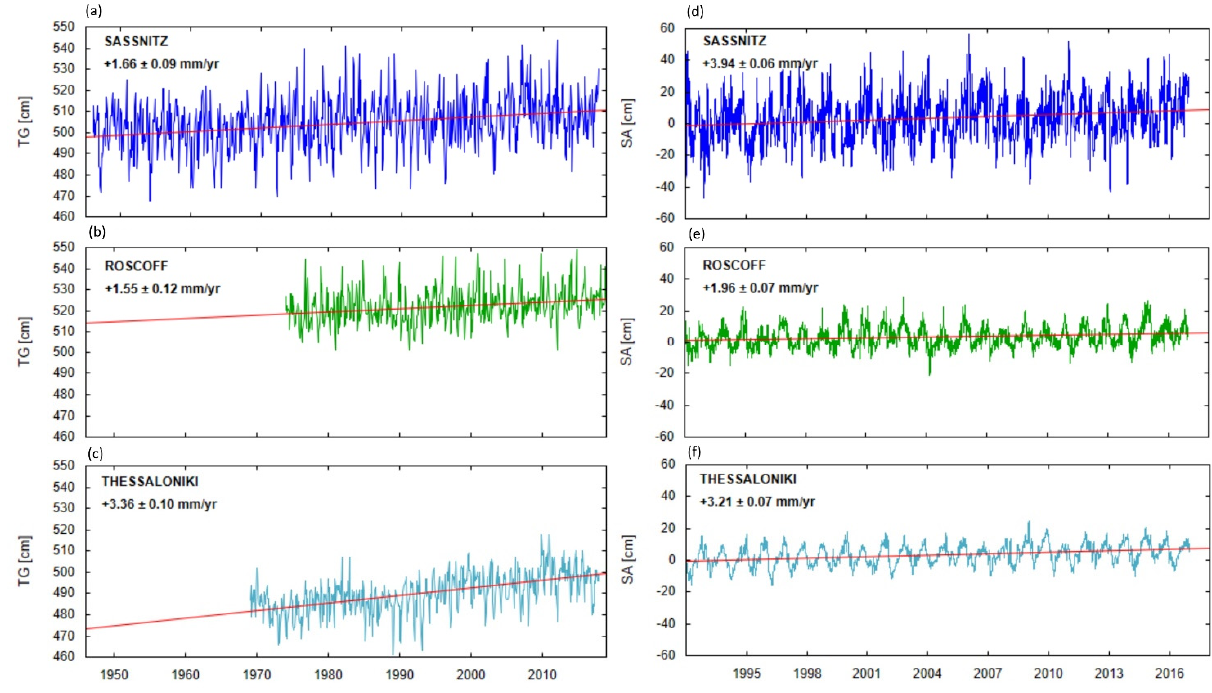
Figure 2. ( a – c ) Time series of mean sea level anomalies based on TG data. ( d – f ) Time series of mean sea levels based on SA data. The time series are displayed with arbitrary offsets for presentation purposes. The units are in centimetres. Gridded daily sea level anomalies with a resolution of 0.25 × 0.25 degrees and the time series for January 1993 to December 2017 from the Copernicus Marine and Environ- ment Monitoring Service (CMEMS) were used. The time series of altimetric data (one series for each altimetric observation point) were obtained. This set combines data from several altimetry missions. Altimetric measurements were corrected for atmospheric effects (ionospheric delay and dry/wet tropospheric effects) and geophysical processes (solid, ocean, pole tides, loading effect of ocean tides, sea state bias and the inverted barometer AVISO [50] and CMEMS